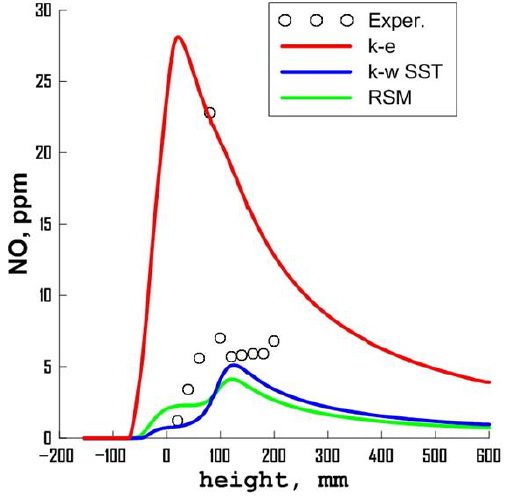
Figure 10. Distribution of temperature and gas composition along the burner axis in the experiment and the calculation for various turbulence models.